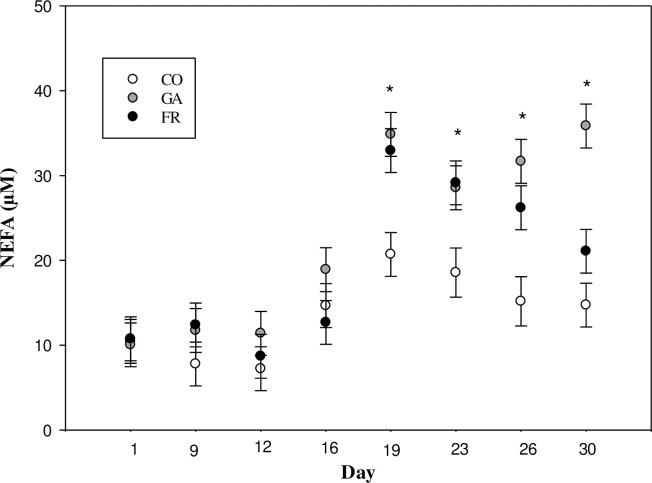
Plasma NEFA (μM) concentration during 30 days of treatment of synchronized ewes.Treatments were: (i) Control (CO): ewes fed a diet that provided the maintenance nutrient requirements for a ewe and given a daily subcutaneous (SC) saline infusion (0.1mL/kg body weight, BW); (ii) Feed restriction (FR): ewes were fed a diet restricted to 80% of maintenance and given a daily SC saline infusion (0.1mL/kg BW); (iii) Ghrelin antagonist (GA): the same restricted diet as the FR and given a daily SC ghrelin antagonist infusion (7.5μg/Kg BW of [D-Lys3]-GHRP-6 diluted into 0.1ml/kg BW of saline solution). The FR and GA ewes increased their NEFA plasma concentration during the experiment in comparison with CO showing a time by treatment interaction (P = 0.01). * indicate treatments differences (P ≤ 0.04) evaluated using the SLICE option in SAS.